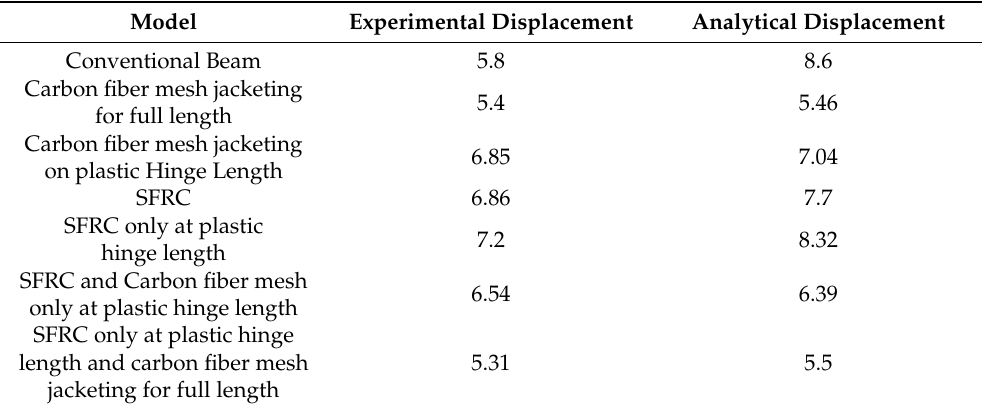
Table 11. Comparative study of displacements predicted from the experiments against analytical predictions.